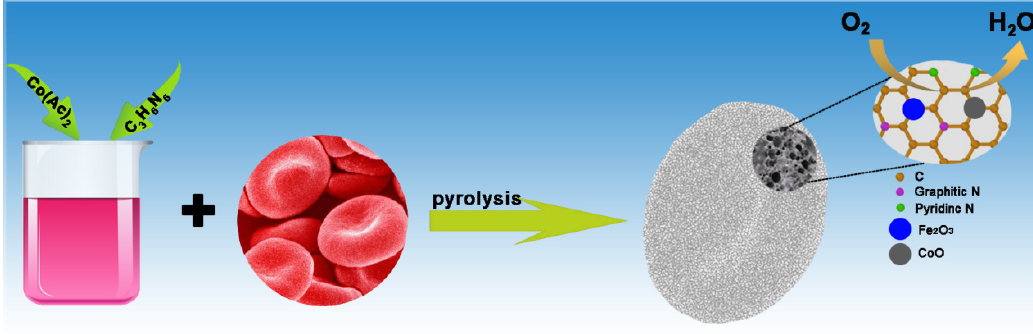
Figure 1. The formation process of FeCo-N/C (RBC) . The morphology and structure of the catalysts were analyzed by FESEM and